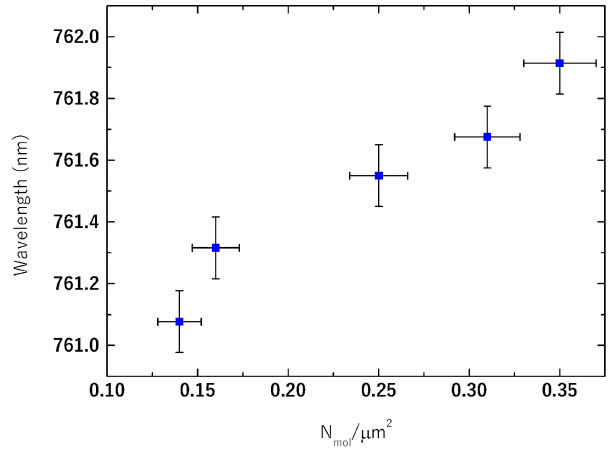
Figure 7. Resonance peak wavelength as a function of the p53 • MDM2 complex surface density on the